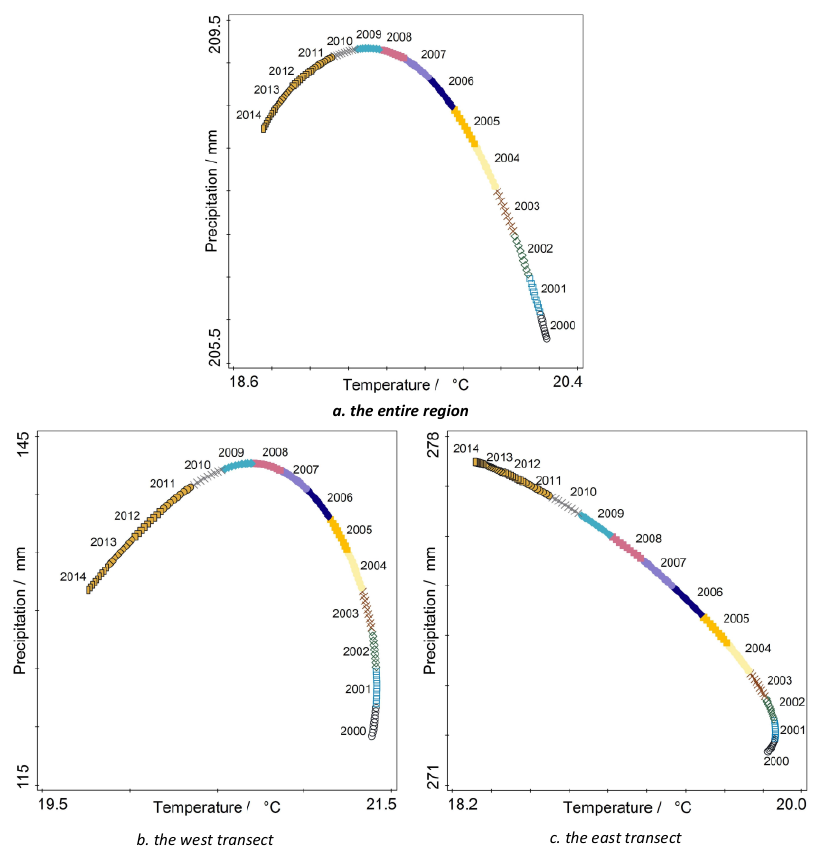
Figure 7. Relation between temperature and precipitation after EMD extraction. (a. the entire region; b. the west transect; c. the east transect)